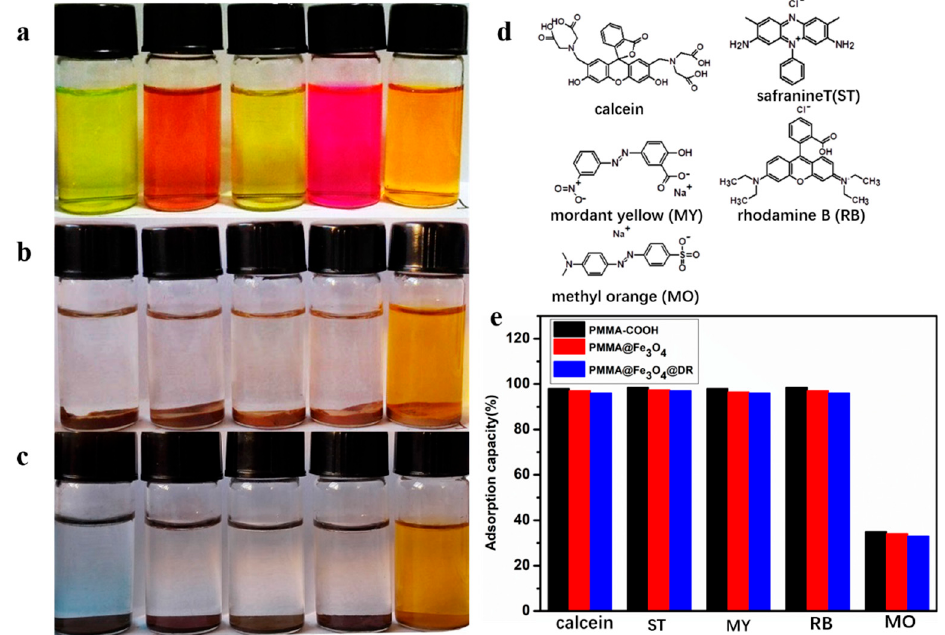
Figure 6. Photographs of aqueous solutions of dyes ( a ) before; ( b ) after adsorption on PMMA@Fe 3 O 4 adsorbent; and ( c ) after adsorption on PMMA@Fe 3 O 4 @DR adsorbent (from left to right: calcein, ST (safranine T), MY (mordant yellow), RB (rhodamine B), and MO (methyl orange) solution and the initial concentration is 50 mg/L ); ( d ) Chemical structures of dyes used for adsorption; ( e ) Saturated